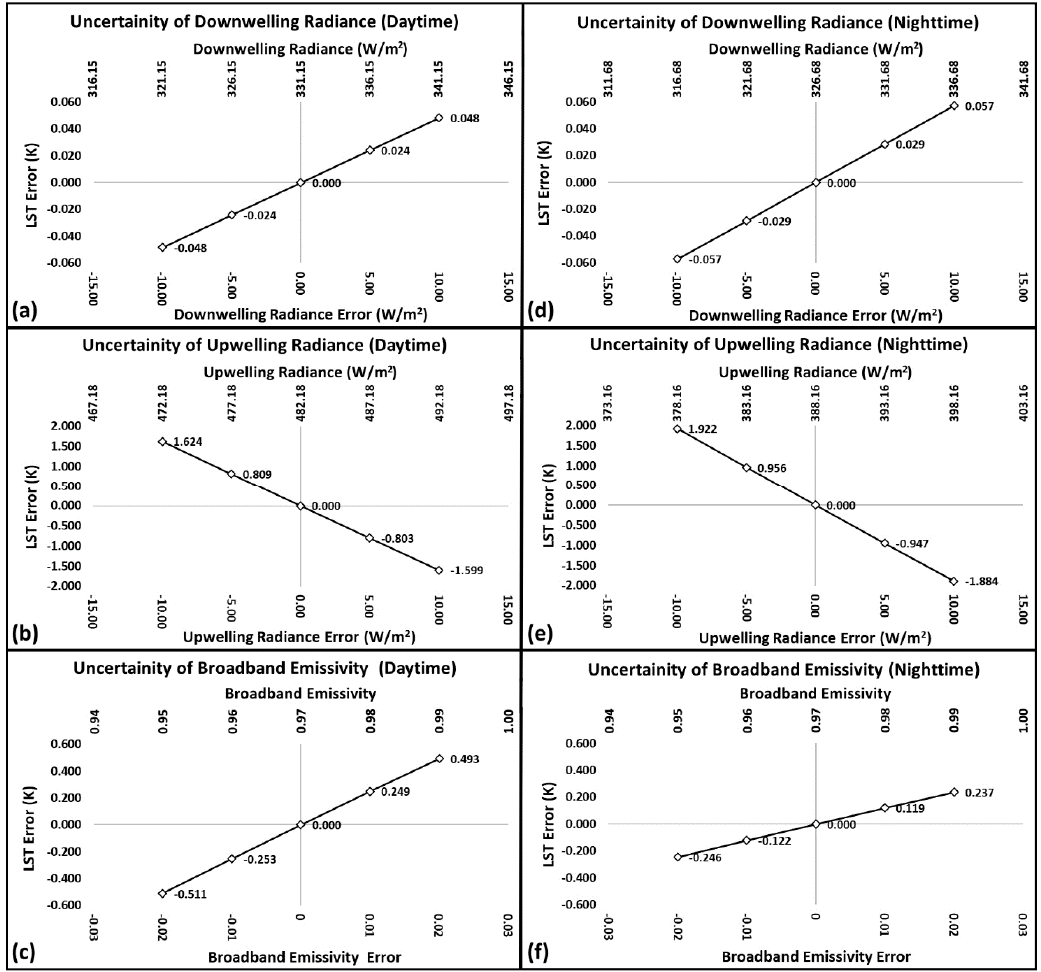
Figure 2. Sensitivity results of in-situ Land Surface Temperature (LST) measurements to downwelling radiance, upwelling radiance, and broadband emissivity, respectively, for both daytime ( a – c ) and nighttime ( d – f ). LST error is computed as in Equation (16).